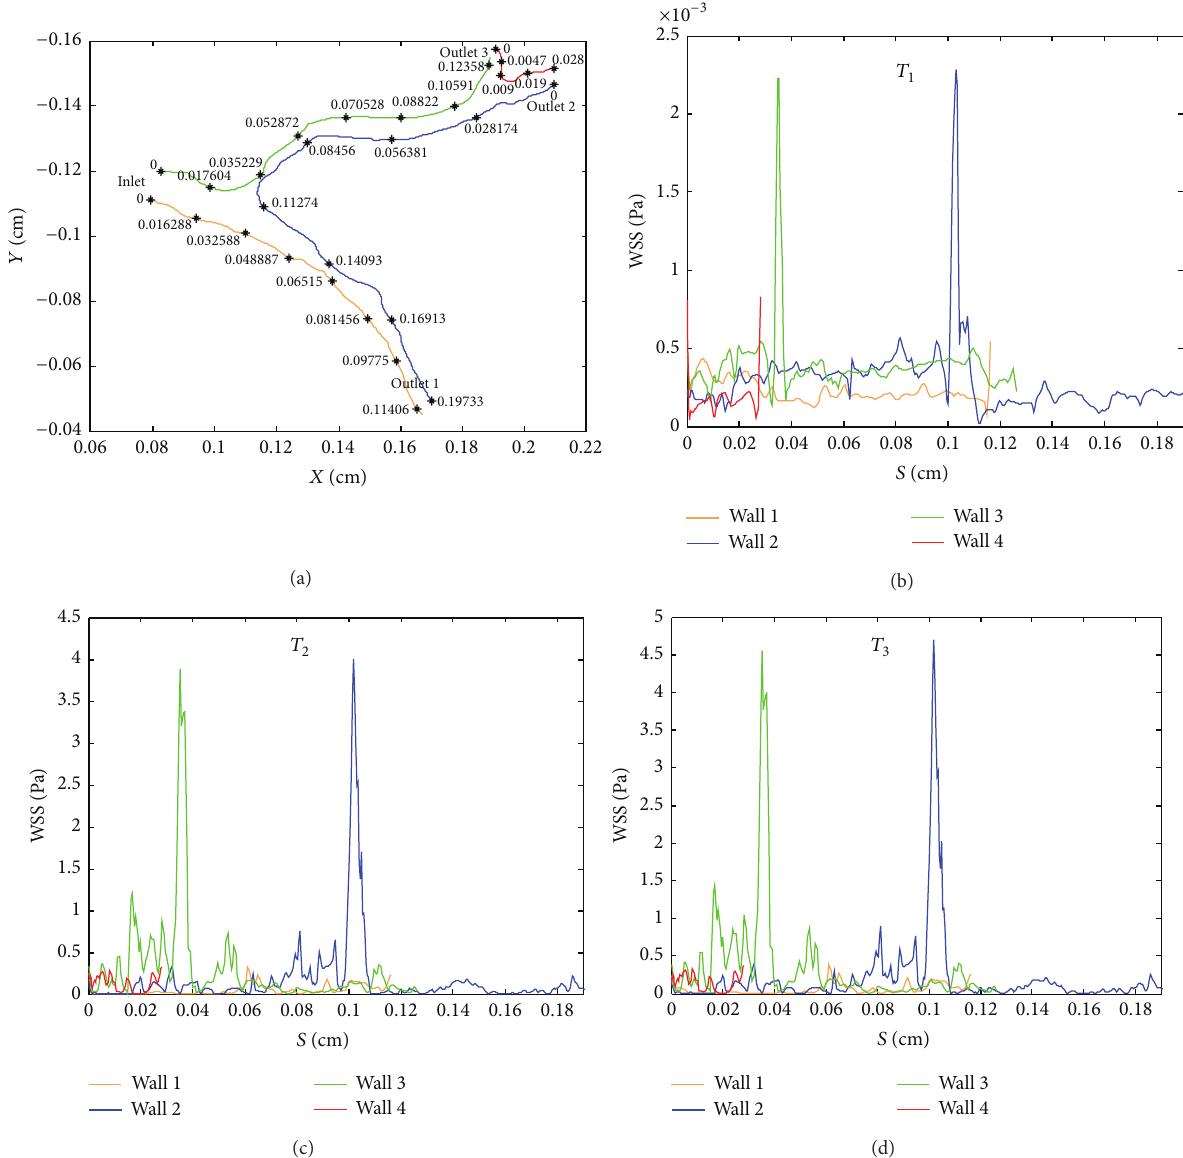
Figure 5: (a) Boundary plots of coronary arterial walls 1, 2, 3, and 4 shown in red, green, blue, and brown, respectively. (b)–(d) WSS distribution along coronary walls at time 𝑇 1 , 𝑇 2 , and 𝑇 3 ,